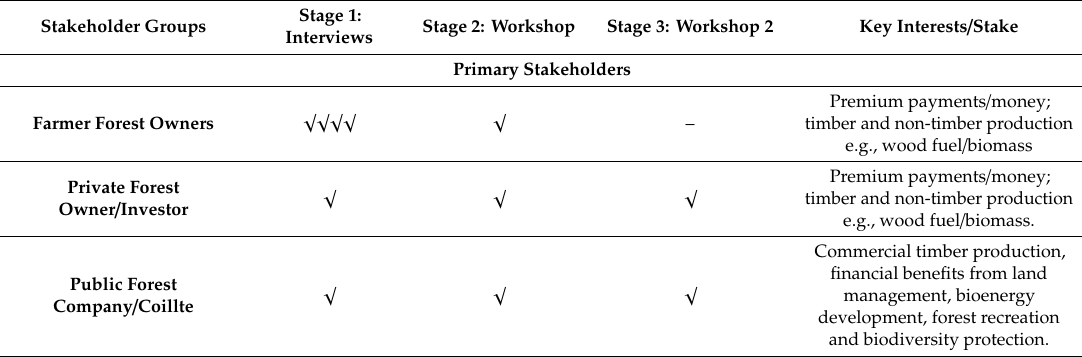
Table A1. Stakeholder groups involved in the Western Peatland interviews / workshops and their interests. Source: Bonsu, Dhubh á in and O’Connor